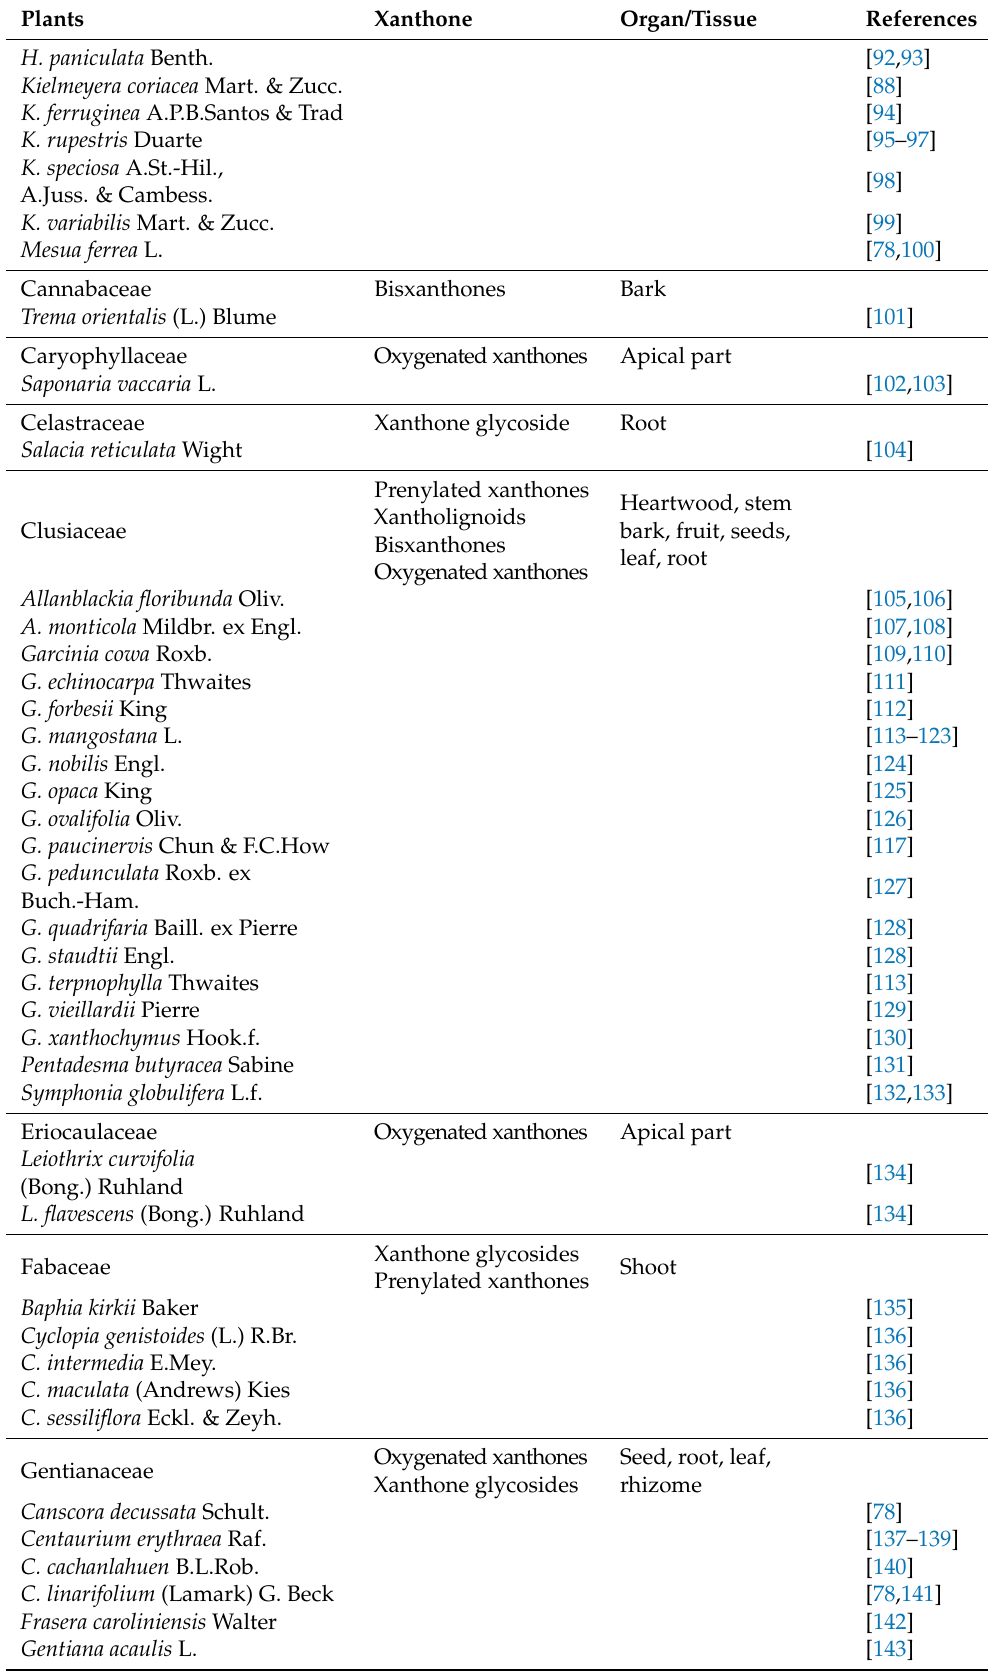
Table 1. Cont. Plants Xanthone